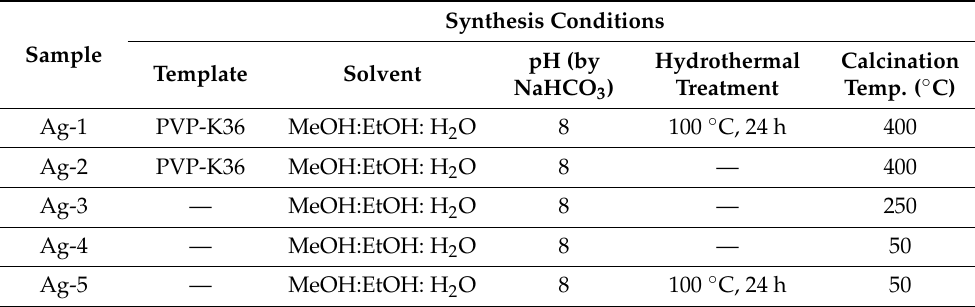
Table 3. Different synthesis conditions adapted to prepare silver containing